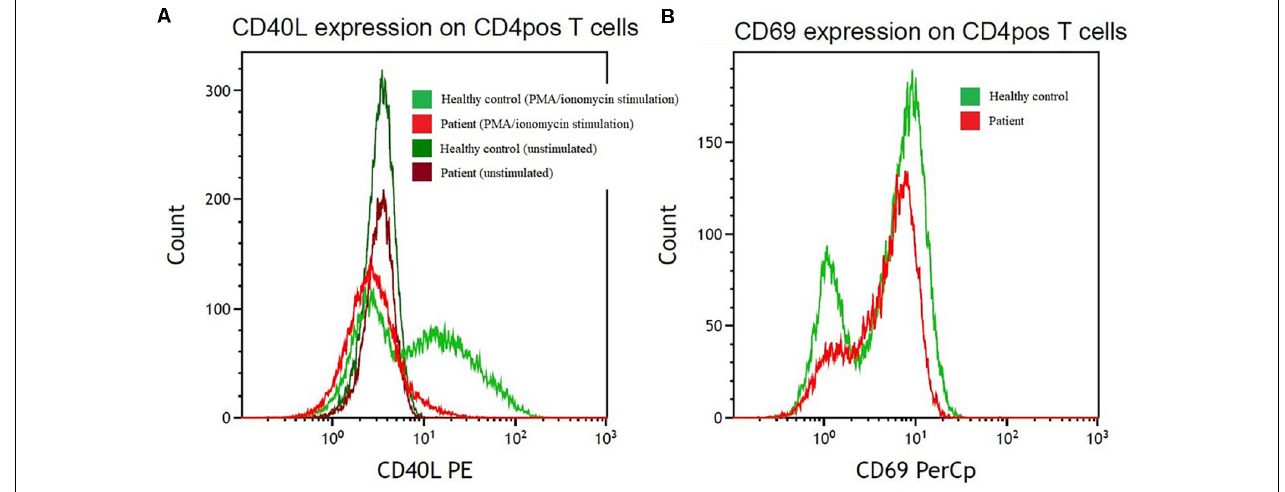
FIGURE 3 | Reduction in cell surface levels of CD40L in CD4pos T cells from the index patient compared with a control individual. (A) CD40L expression after PMA/ionomycin stimulation (light red/light green) on CD4pos T-cells and on unstimulated (dark red/dark green) CD4pos T-cells from the index patient (red colors) compared with healthy control (green colors). (B) Control of PMA/ionomycin stimulation monitored by CD69 upregulation on CD4pos T cells in the patient (light red) and a healthy control (light green). PE, phycoerythrin; PerCP, peridinin chlorophyll protein